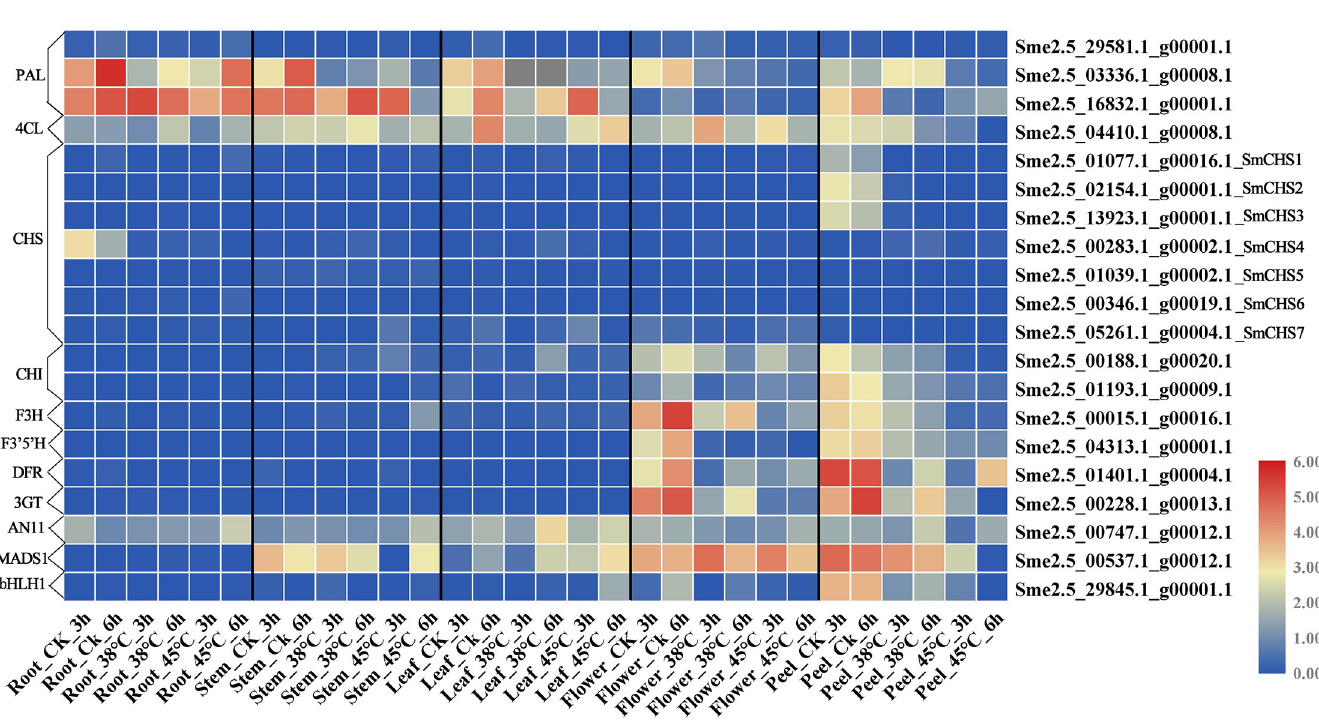
S1 Table. CHS protein sequences of Solanum species. S2 Table. Features of CHS genes identified in Nicotiana tabacum. S3 Table. Primers used for real time PCR analysis. S1 Fig. Sequence alignment of all 73 CHS proteins of Solanum specie. Color bars on the left represent the 10 groups in Fig 4. Active site residues are highlighted in yellow, malony-CoA binding sites are highlighted in blue and other conserved sequence are shown in green. S2 Fig. Interaction network key to anthocyanin biosynthesis in eggplant. The pink labels represent the CHS gene family.